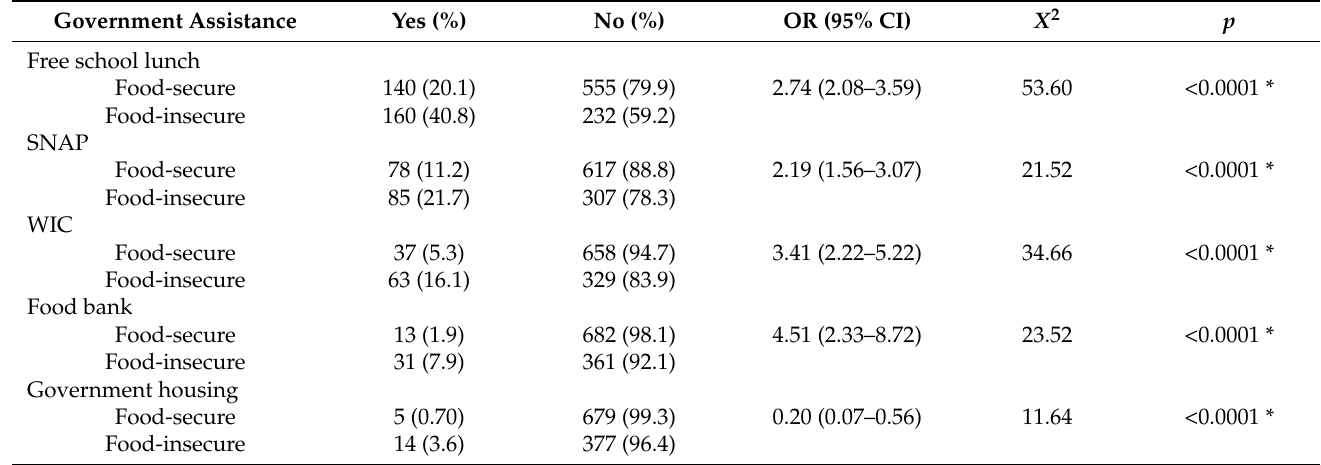
Table 2. Chi-square analysis of childhood access to government assistance based on food security status of undergraduate college students.